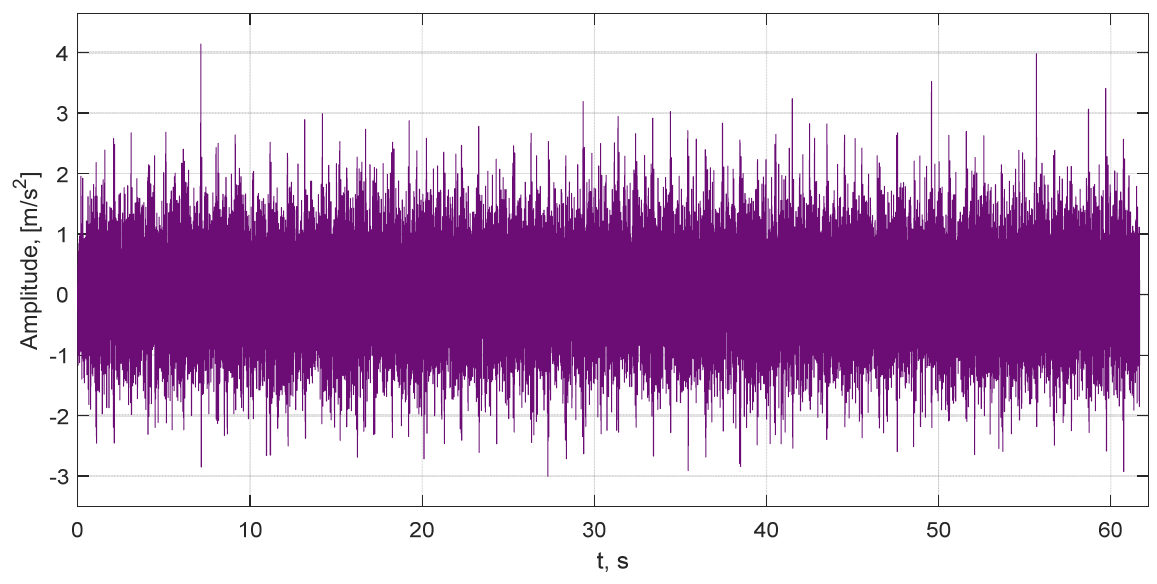
Figure 5. The theoretical seismocardiogram signal with different types of noises.